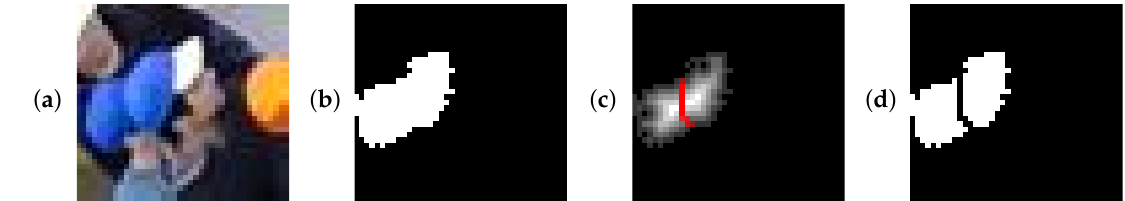
Figure 11. Example of segmenting two adjacent detections (blue hats) employing the watershed transform: ( a ) original frame, ( b ) original binary mask, ( c ) binary distance with indication of watershed line and ( d ) binary mask after application of watershed segmentation.